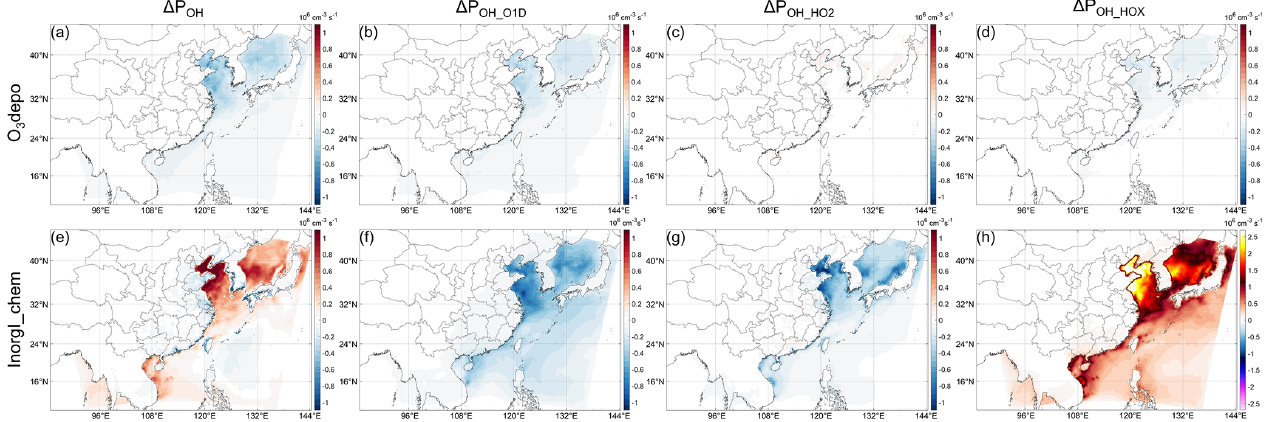
Figure 7. Decomposition of Fig. 4e–h (InorgI): the changes in net OH production rate caused by (a) – (d) the enhanced O 3 deposition by oceanic iodine ions and (e) – (h) atmospheric iodine chemistry (including direct HOI emission). The red and blue color scales are the same in (a) – (h)